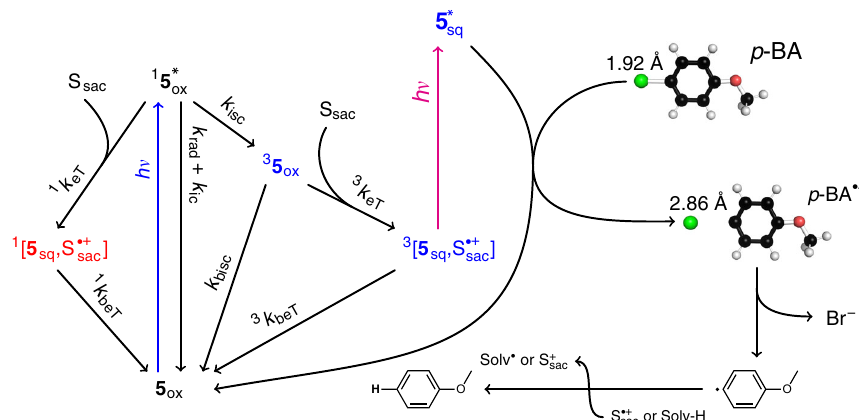
Fig. 6 Photocatalytic reaction mechanism. A sacri fi cial electron donor, e.g. DIPEA, reacts either with the excited singlet or triplet state of the deaza fl avin. In the excited singlet state reaction, a singlet born spin correlated radical pair, 1 [ 5 sq , S (cid:129) þ formed. In contrast, eT to the triplet state results in a triplet born radical pair, 3 [ 5 sq , S (cid:129) þ be excited by a second photon enabling a consecutive photo-induced electron transfer from 5 sq * to the substrate, p -BA, regenerating 5 ox in its ground state and closing the photocatalytic cycle. Finally, anisole is formed via hydrogen abstraction from either a S (cid:129) þ